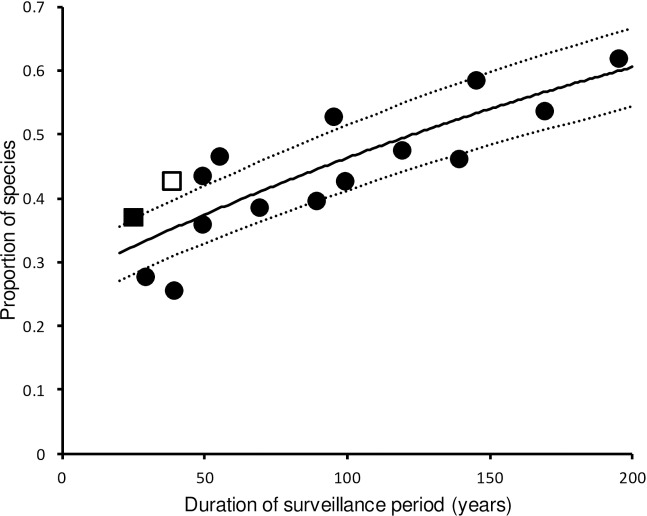
Proportion of UK breeding bird species with at least one assessment period in which there was a population decline in relation to the duration of the composite surveillance period over which population status was assessed.Filled symbols represent results based upon the population trend scores from Gibbons, Avery & Brown [21] (GAB). The filled square is for the most recent of the GAB periods (1970–1995), which overlaps with the period of our analysis of recent population trends (1970–2013). The proportion of species with an SPD, according to our definition, in 1970–2013 is shown by the open square and is plotted at the mean duration of surveillance of the 187 monitored populations for this period. All negative GAB trend scores were classified as declines.